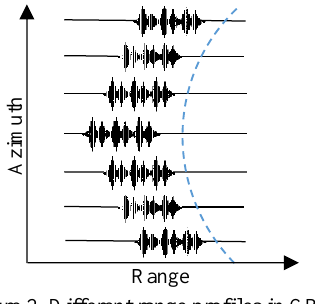
Figure 2. Different range profiles in